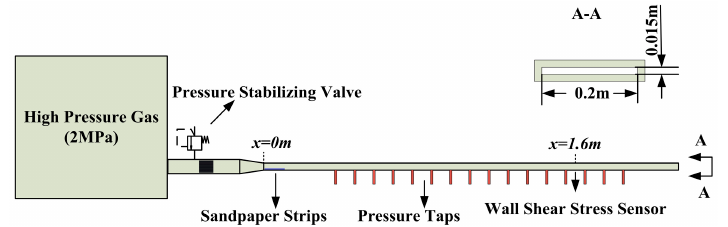
Figure 6. The wind tunnel setup for static calibration of the micro-sensor.